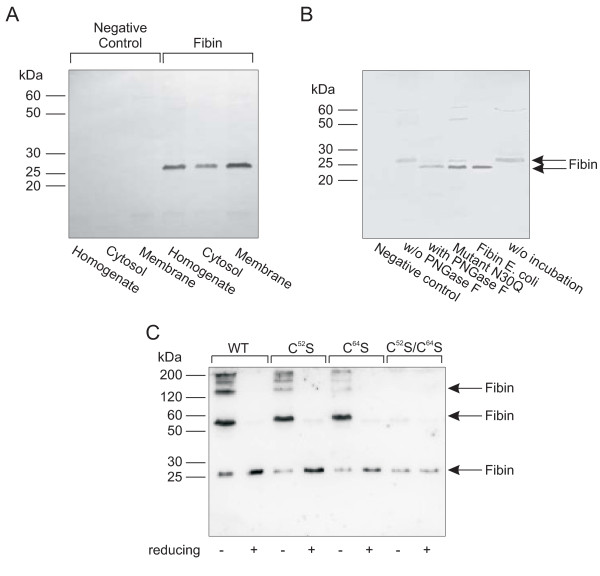
Localization and posttranslational modification of fibin analyzed by Western blotting. (A) To analyze the subcellular distribution of fibin cells were harvested 72 h after transfection followed by preparation of the homogenate, the cytosolic and the membrane fraction. 50 μg of protein were applied to each lane. (B) For deglycosylation experiments, fibin expressed in COS-7 cells was incubated either with or without (w/o) PNGase F or not incubated (w/o incubation). Furthermore, the fibin mutant N30Q lacking the N-glycosylation site, was expressed in COS-7 cells and fibin lacking the signal sequence were expressed in E. coli (Fibin E. coli). Immunoblots (A) and (B) were performed with anti-fibin-1-antibodies. (C) Wild-type (WT) fibin, and the fibin mutants C52S, C64S, C52S/C64S were expressed in COS-7 cells. After 72 h, cells were harvested and lysates were prepared. Equal amounts of protein were loaded and separated by SDS-PAGE under either non-reducing or reducing conditions. For immunoblotting the anti-fibin-2 antibody was applied. Negative controls (NC) were prepared as described under Methods.